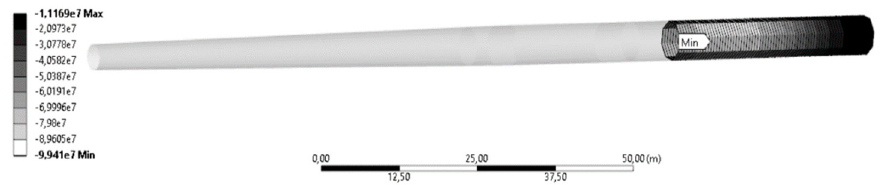
Figure 19. Axial stress distribution on the PILE288 elements of the penetrated monopile for the Pt 0 soil model.